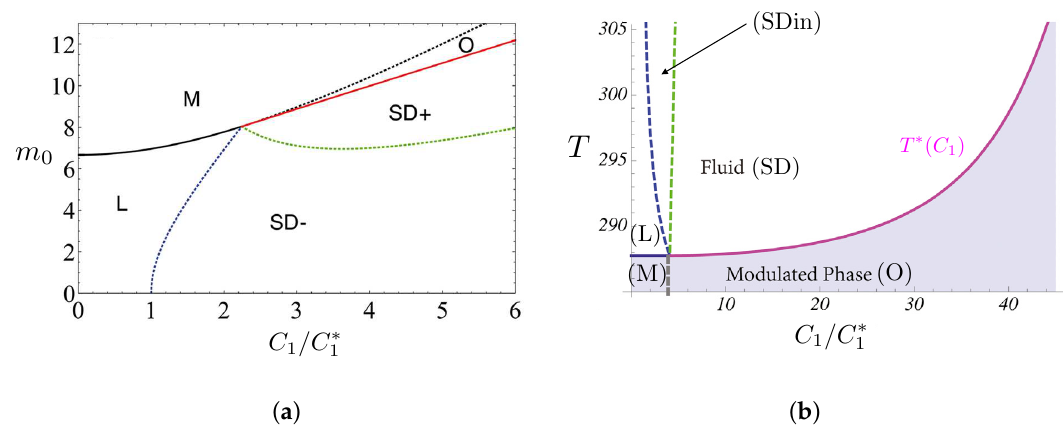
Figure 2. Examples of phase diagrams showing the formation of curvature-induced domains in planar membranes. Each diagram shows 3 phases: the macrophase separation (M), the modulated phase (or mesophase) (O), and the liquid phase which can be simple (L) or structured disordered (SD) with transient domains. ( a ) Coupling constant between the two leaflets m 0 versus C 1 / C ∗ (see text) from 1 the model by Gueguen et al. in which the two leaflets have the same composition but with different averaged area fractions. SD- (resp. SD+) corresponds to curved (resp. flat) transient domains. Here the bending modulus κ does not depend on the phase state. Reproduced from [85], with permission of The European Physical Journal (EPJ), Copyright 2014. ( b ) Temperature versus C 1 / C ∗ from the 1 model by Shlomovitz and Schick in which each leaflet contains a different mixture of two lipids. (SDin) Fig. 2. (a) Dimensionless structure factor ˜ S (˜ q ) corresponding corresponds to curved transient domains in the inner leaflet only, and (SD) in both leaflets. Adapted to the 4 regions of the phase diagram (b) ( ℓ + /ξ = 0 . 5, ℓ /ξ = − from [79], with permission from Elsevier, Copyright 0 . 3): Liquid phase (L) in red (( ξ/ℓ 0 ) 2 = 6 . 64, C 1 /C ∗ 1 = 0 . 25); Macrophase separation (M) in blue (( ξ/ℓ 0 ) 2 = 6 . 69, C 1 /C ∗ 1 = 0 . 25); Structure Disordered (SD ) in green (( ξ/ℓ 0 ) 2 = 9 . 97, − C 1 /C ∗ 1 = 4); and Ordered phase (O) in black (( ξ/ℓ 0 ) 2 = 9 . 99, C 1 /C ∗ 1 = 4). Inset: Blue and black curves on a larger scale. (b) Corresponding phase diagram where ( ξ/ℓ 0 ) 2 m 0 is the ∝ coupling between ψ + and ψ , and C 1 is the local curvature − induced by ψ . (c) Correlation function associated to the three − structure factors shown in (a) : L (in red), SD in green and − O in black. FIGURE 2 Phase diagrams of the system for three different couplings between the leaves. Each diagram exhibits four phases: For any coupling